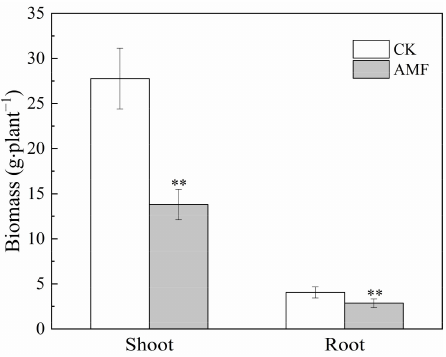
Figure 3. Effects of AMF on biomass of maize under 20 mg · L − 1 Cd concentration stress. Error bar indicates standard deviation, n = 4. CK represents the control of non-inoculation, Cd represents cadmium. AMF represents Funneliformis mosseae inoculation. “**” mean p < 0.01 according to the LSD test.